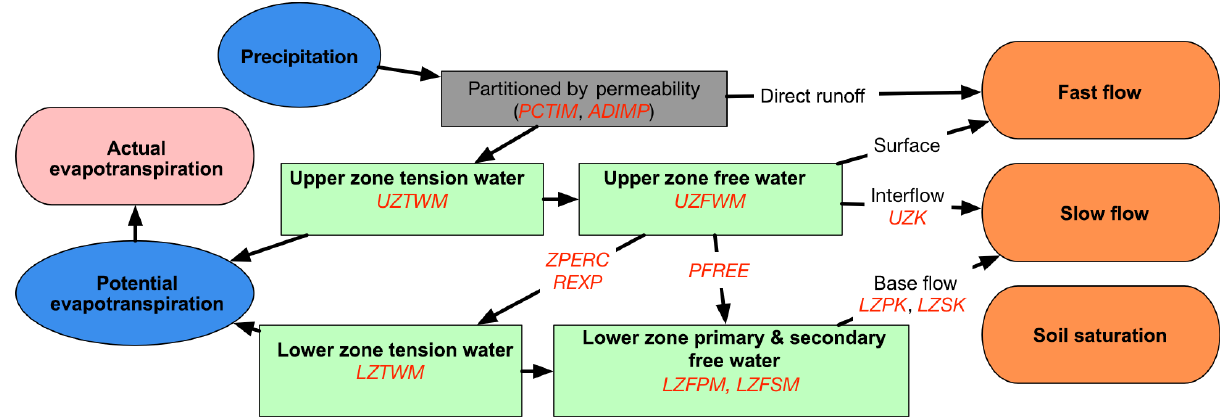
Figure 3. A schematic showing the progression of processes, inputs, and outputs represented in the EF5/SAC-SMA water balance